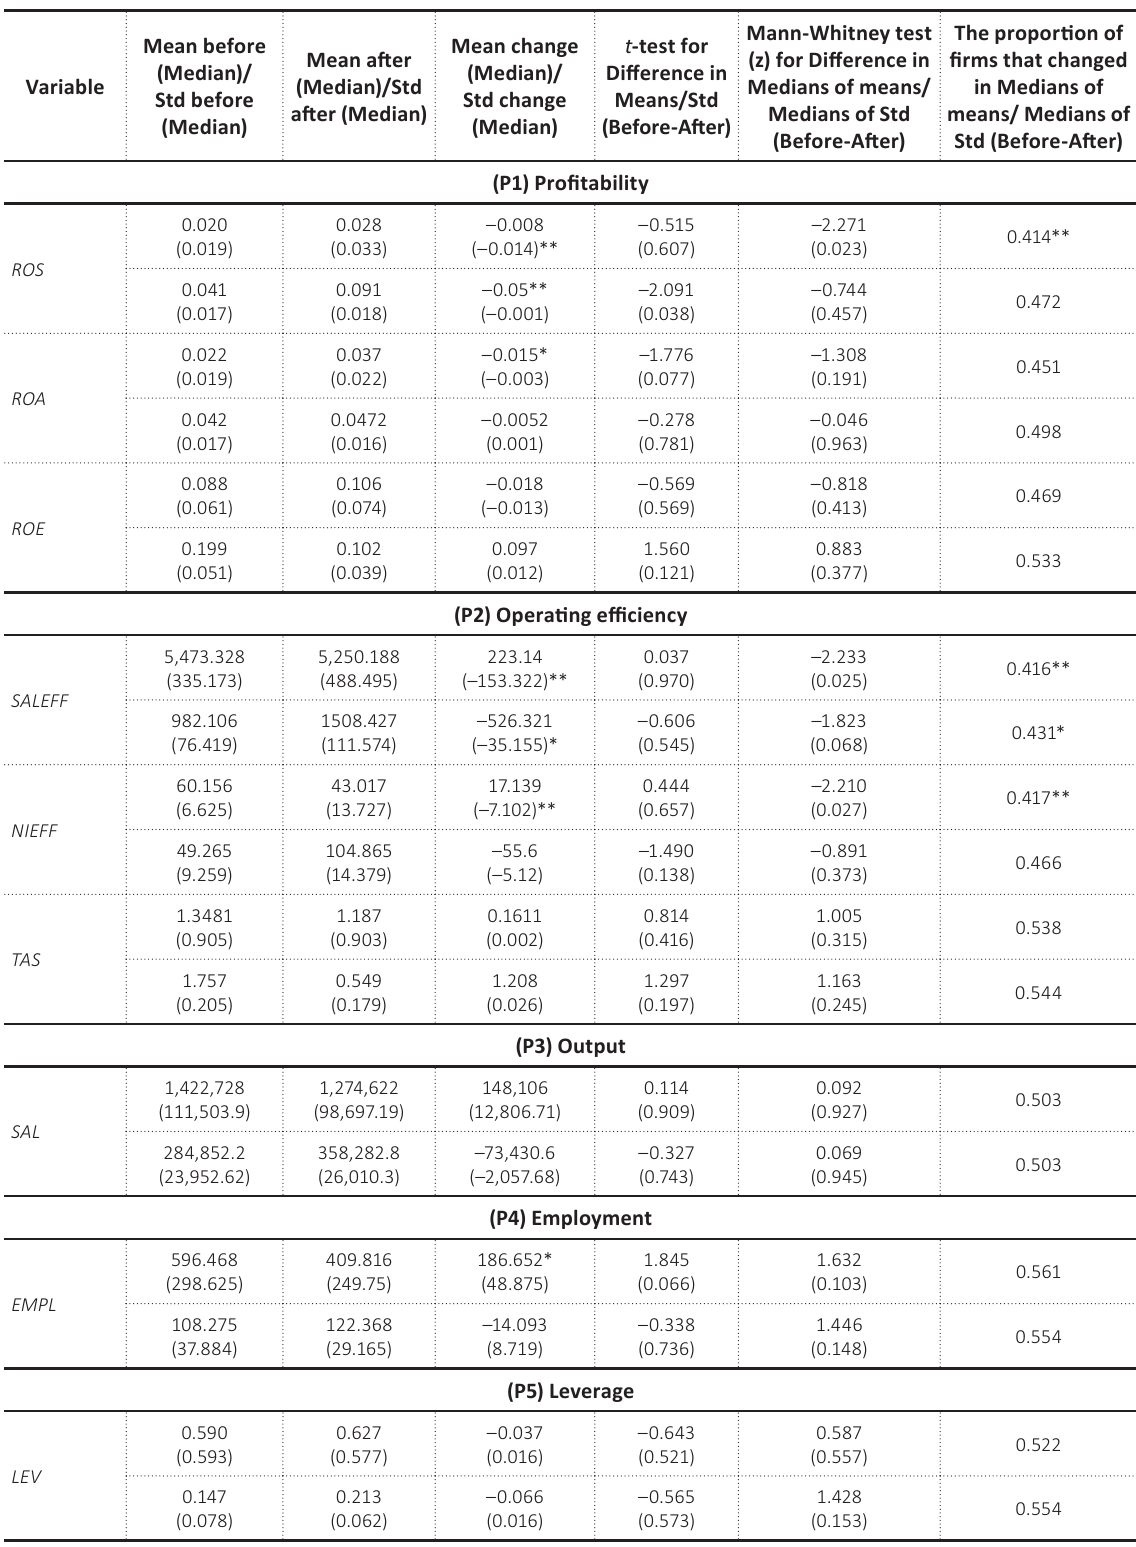
Table 7. Testing results of predictions for privatized SOEs without corporate income tax